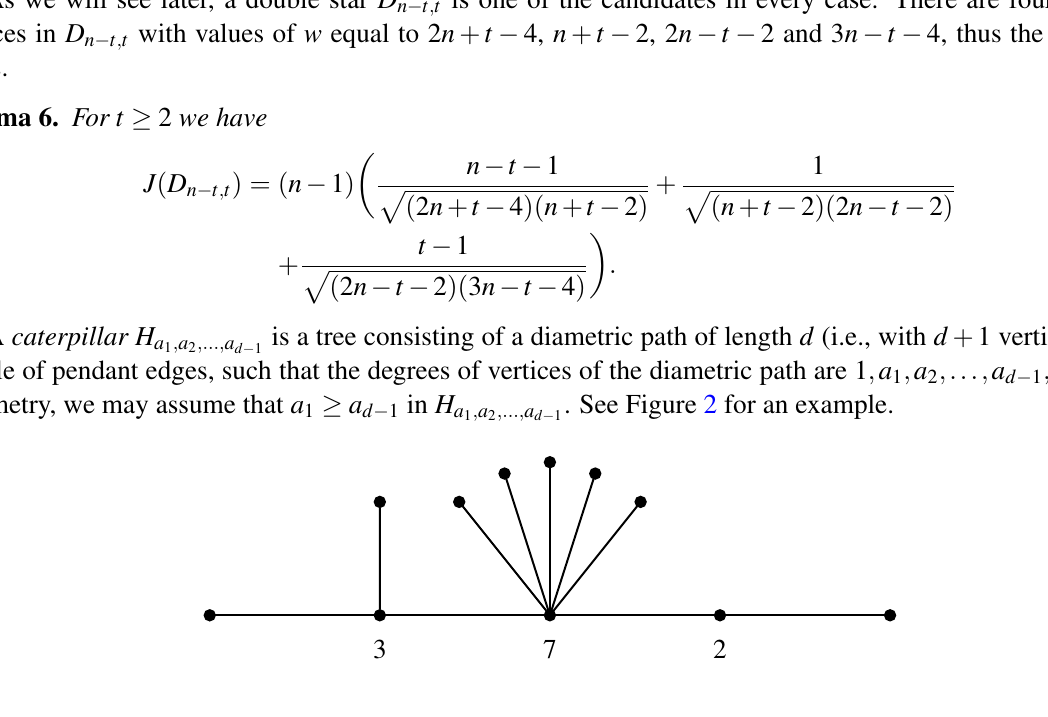
Fig. 2 A caterpillar H 3 , 7 , 2